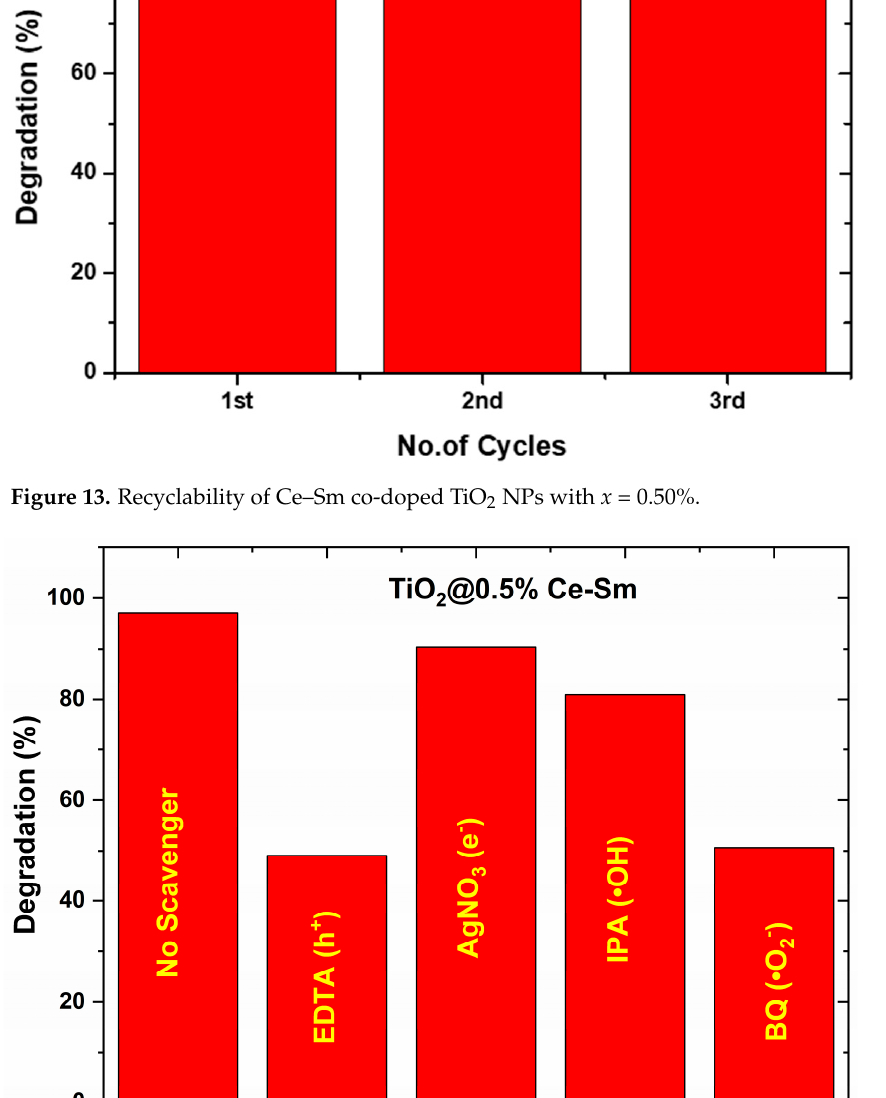
Figure 14. Test of scavenger’s e ff ects of Ce–Sm co-doped TiO 2 NPs with x =